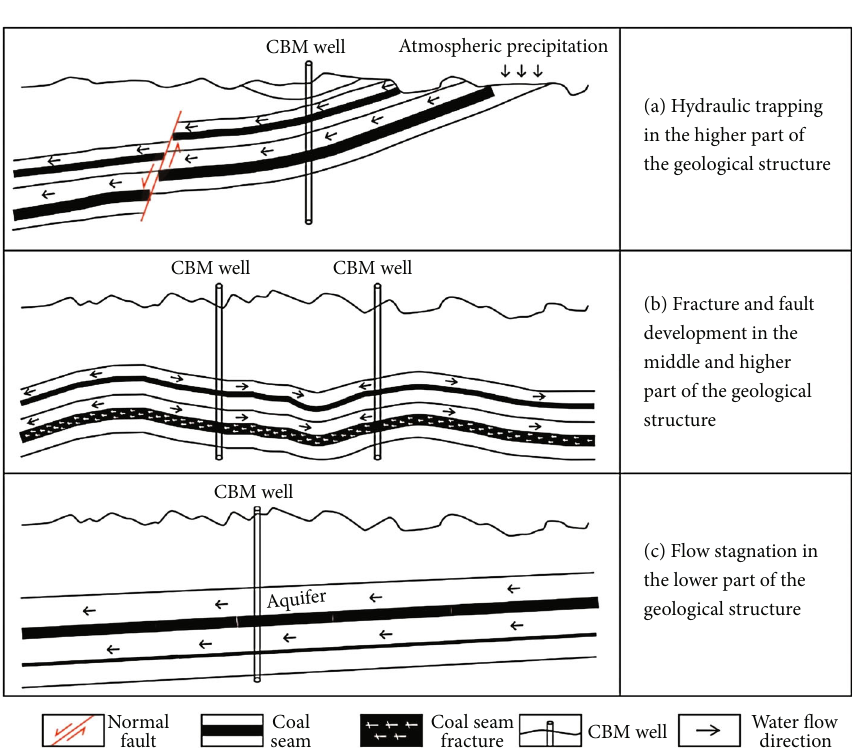
Figure 4: Schematic diagram of high-yield patterns of CBM